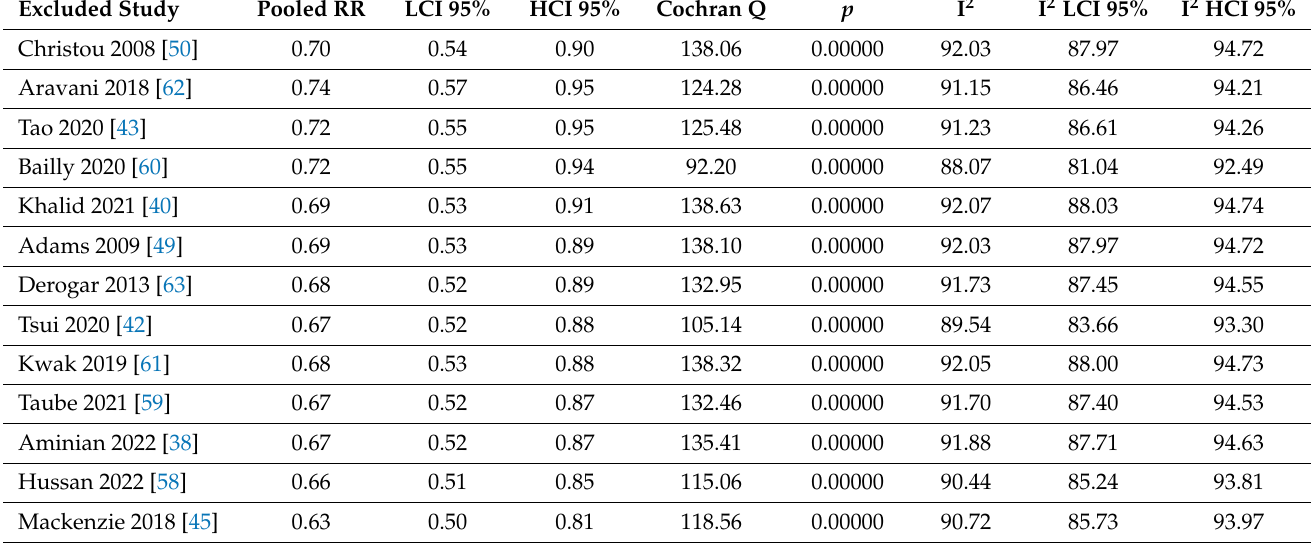
Table A9. Colorectal cancer random effects model sensitivity